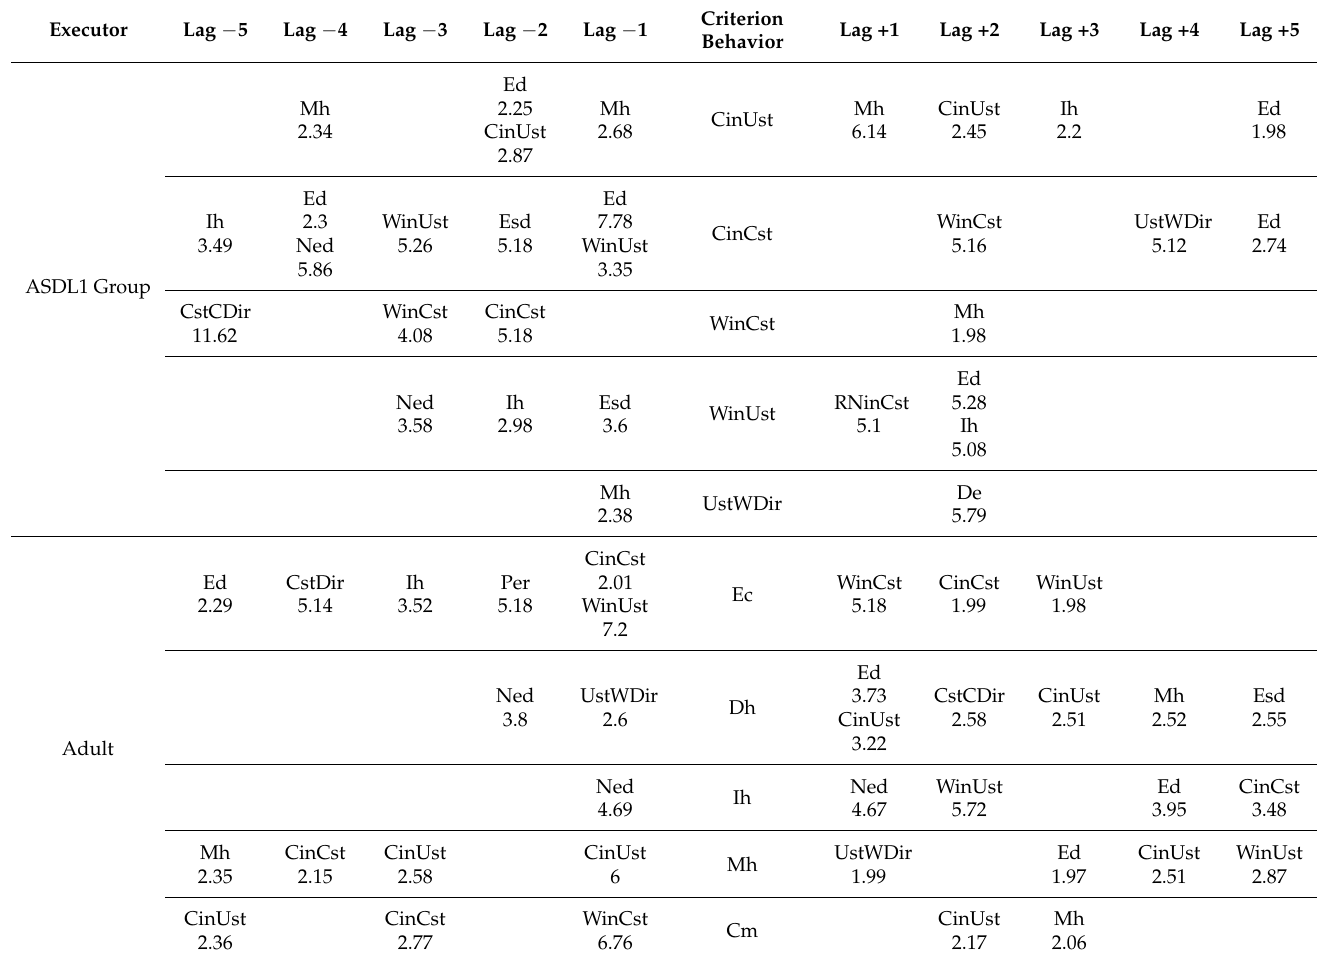
Table 3. Behavioral patterns obtained in the ASDL1 Group in the middle of the intervention. Central column = It contains the criteria behaviors. Remaining cells = They contain the conditional behaviors. Numbers = Significant adjusted residuals values. Green codes = The most relevant behaviors indicating children progress in interference control. Red codes = The most relevant wrong interference control behaviors of the children. Blue codes = The most relevant adult scaffolding